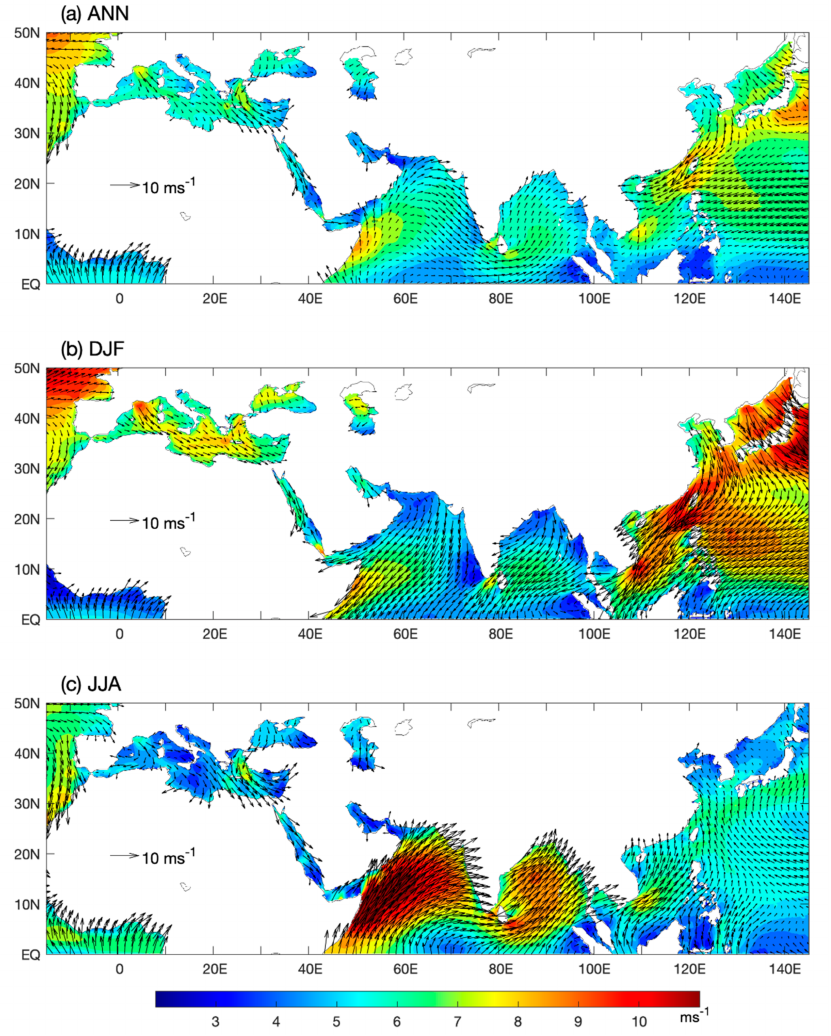
Figure 6. Mean wind speed (shaded by colors) and direction. ( a ) Annual mean, ( b ) winter season (DJF), and ( c ) summer season